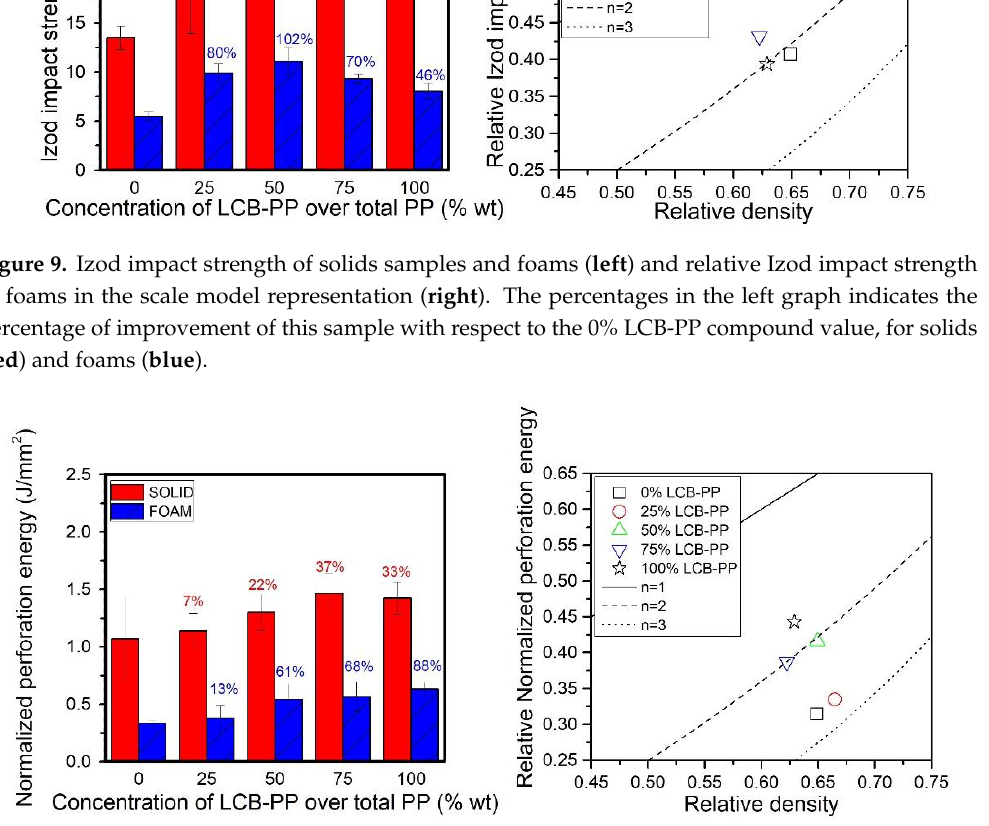
Figure 11. n exponent of each property, following the scale model (Equation (1)). The average is also represented.